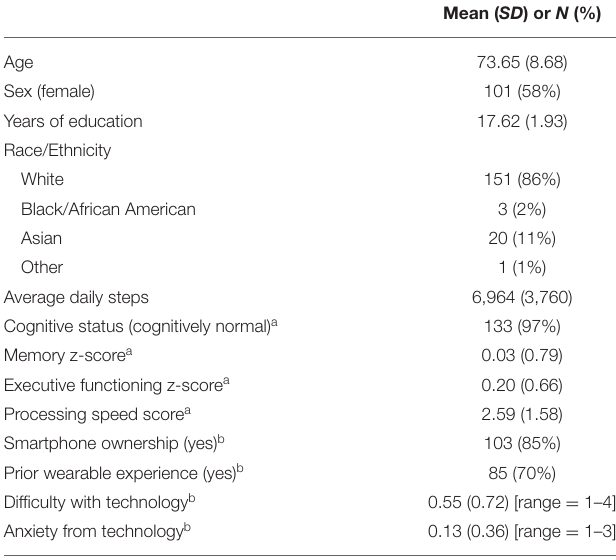
TABLE 1 | Demographic and clinical characteristics ( N =